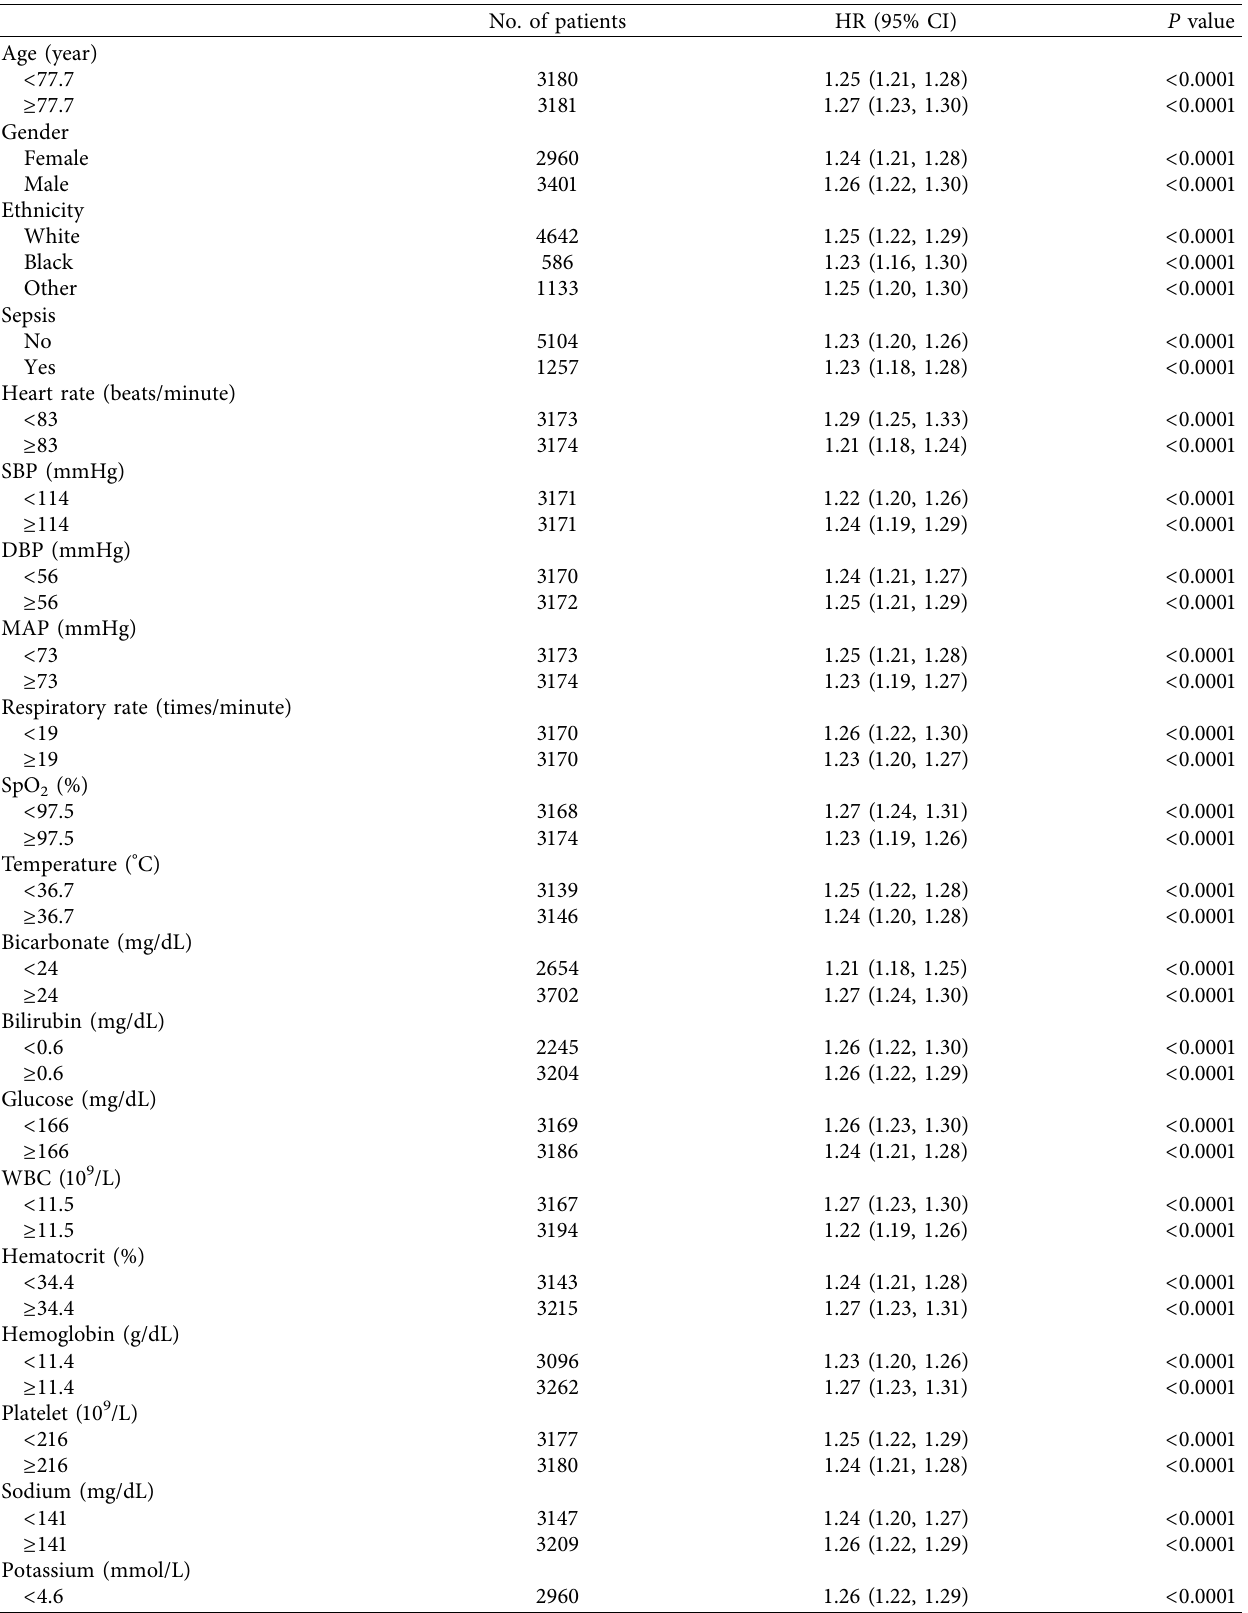
Table 4: Subgroup analysis of the associations between 90-day all-cause mortality and the RA